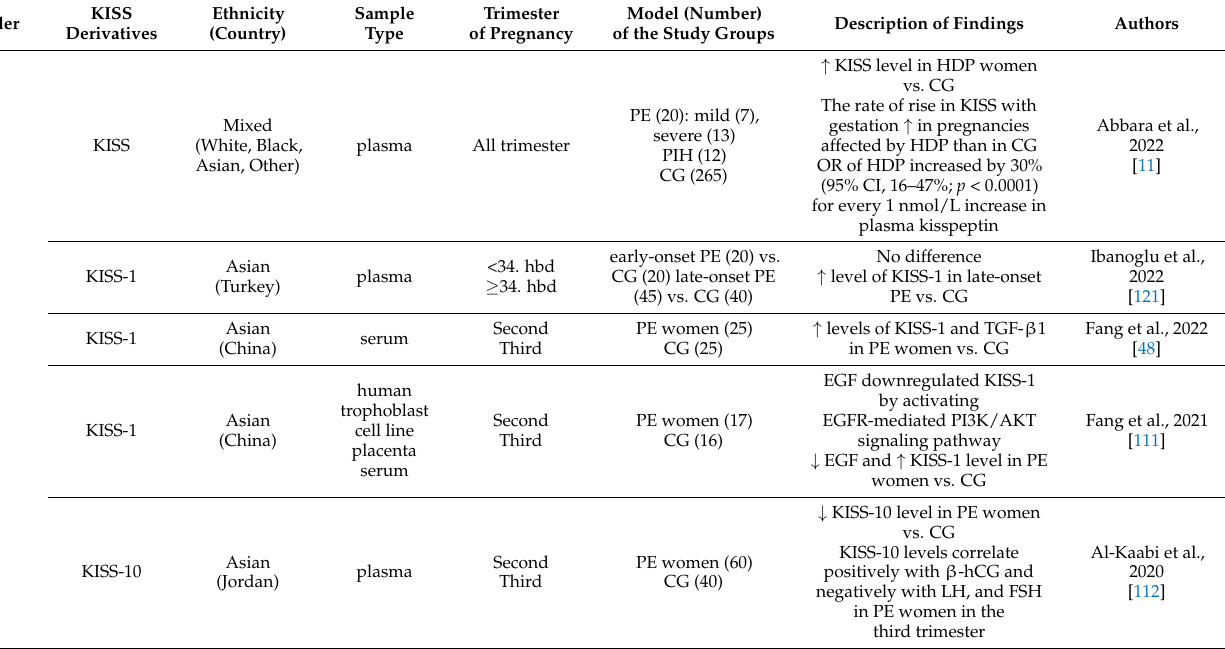
Table 1. Summaries of the studies conducted on the role of kisspeptin in placental